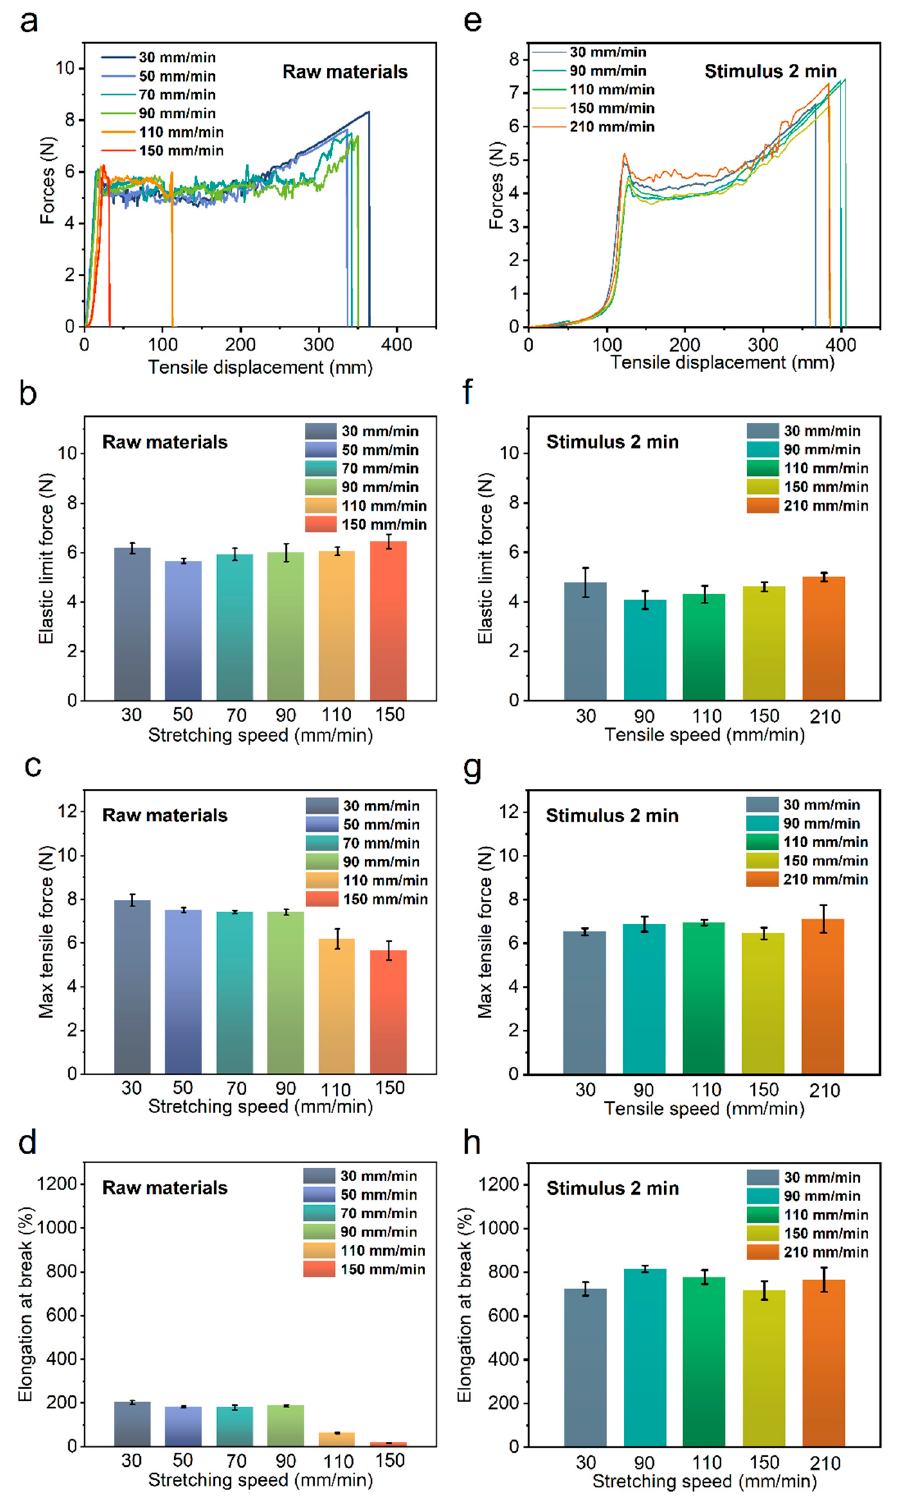
Figure 6. Force versus tensile displacement curves of unstimulated raw bio-inspired spider silk samples at different tensile speeds ( a ); elastic limit force ( b ); maximum tensile force ( c ); elongation at break ( d ). Force versus tensile displacement curves for bio-inspired spider material stimulated at 60 ◦ C for 2 min at different tensile speeds ( e ); elastic limit force ( f ); maximum tensile force ( g ); elongation at break ( h